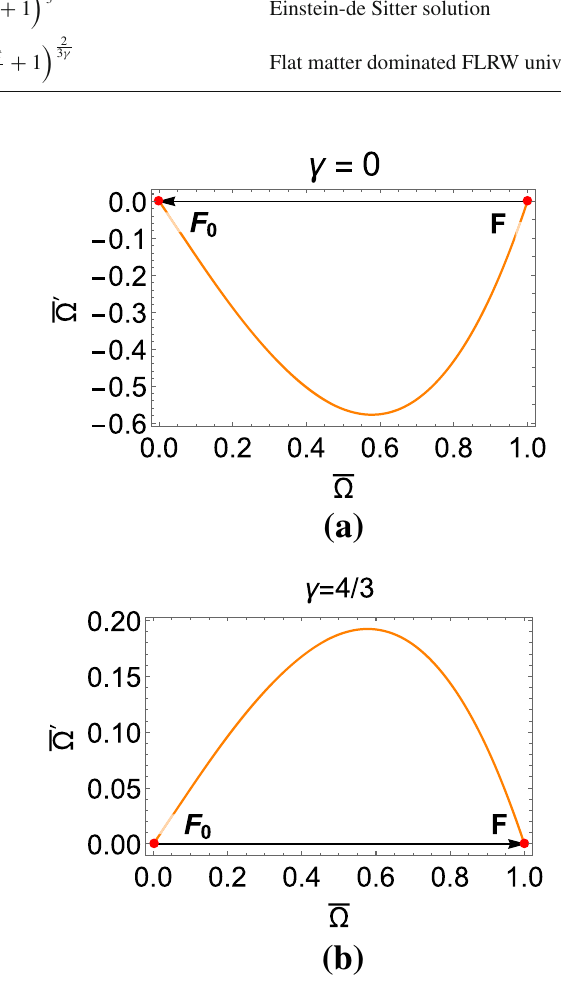
Fig. 2 Phase plot of Eq. (98a) for different choices of γ